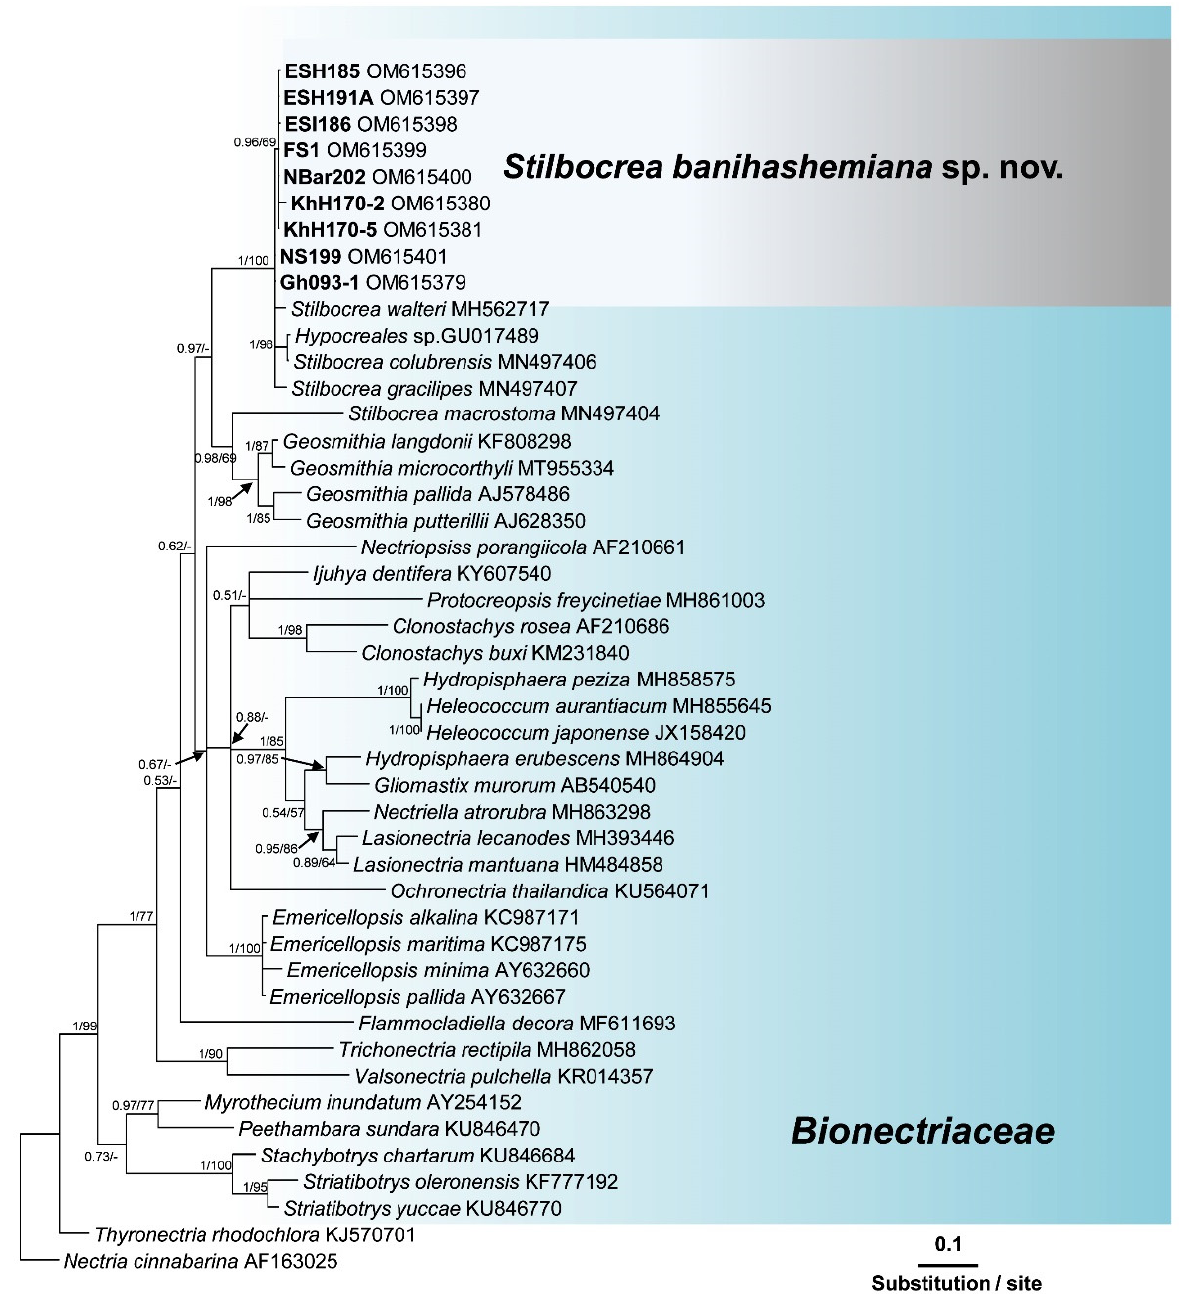
Figure 2. Phylogenetic position of Stilbocrea banihashemiana sp. nov. from infected fig and loquat trees sampled in Fars Province, Iran within Bionectriaceae : relationships among 35 Bionectriaceae members based on Bayesian analysis of ITS (internal transcribed spacers 1 and 2 and 5.8S gene of rDNA) sequences. Isolates in bold were sequenced in the present study. Numbers on the nodes are Bayesian posterior probability values (BI–PP) followed by maximum likelihood bootstrap values (ML–BS). Full supported branches (BI–PP = 1/ML–BS = 100). The tree was rooted to two Nectriaceae members Nectria cinnabarina and Thyronectria rhodochlora . FS1 = ex-type = CBS 148864 Isolates recovered from infected fig, and loquat trees in Iran are indicated in bold . Arrows represent the exact position of supporting values in the phylogenetic